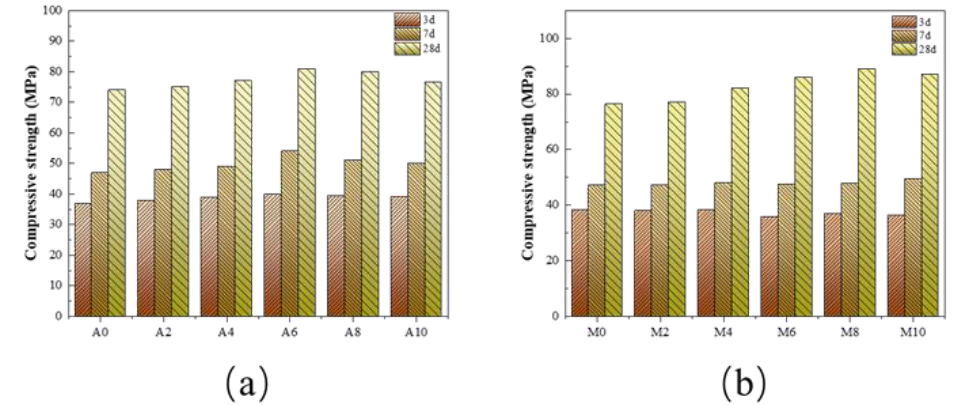
Figure 7. Compressive strength of cement paste samples: ( a ) attapulgite cement paste before and after calcination; ( b ) montmorillonite cement paste before and after calcination.